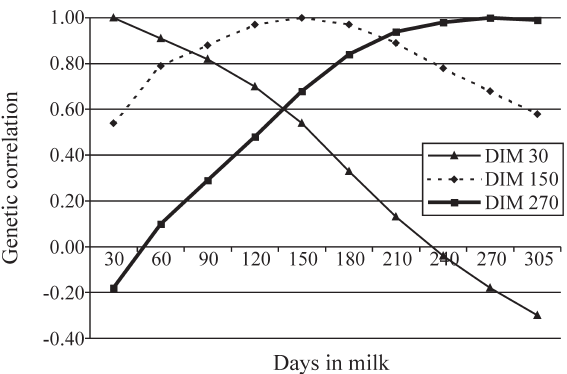
Figure 4 - Genetic correlations between daily milk yield at 30, 150 and 270 days and the other lactation periods obtained by the RRM1 model.